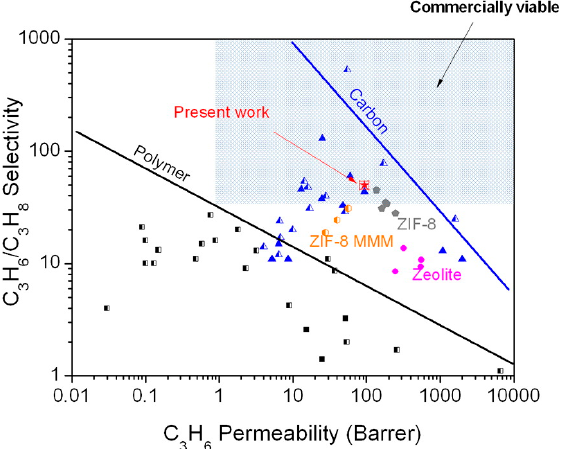
Figure 63. Propylene/propane separation performance of ZIF-8 membranes as a function of growth time at room temperature. ZIF-8 membranes show excellent propylene/propane separation factors (~50) even after growing for 30 min (adapted with permission from ref. [69]).